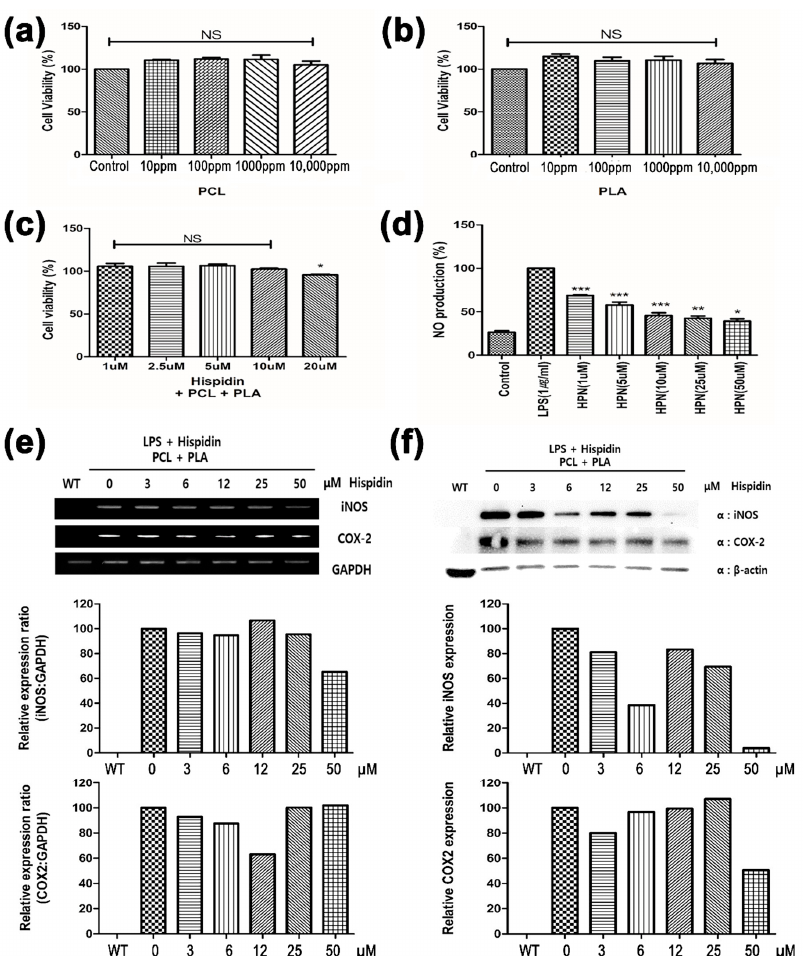
Figure 5. PLA, PCL, and hispidin inflammation in RAW264.7 cells. ( a ) Cells were treated with different concentrations of PLA, ( b ) PCL, and ( c ) hispidin with PLA/PCL, and incubated for 24 h. Cell viability was measured by MTT assay. ( d ) RAW264.7 cells were treated with indicated treatments. Levels of nitric oxide (NO) production were measured using Griess reagent. ( e , f ) The RNA and protein expression levels of inducible nitric oxide synthase (iNOS) and cytochrome c oxidase subunit II (COX-2) were detected by RT-PCR and Western blot testing, and the results were quantified. * p < 0.05, ** p < 0.01, *** p < 0.001 versus control.